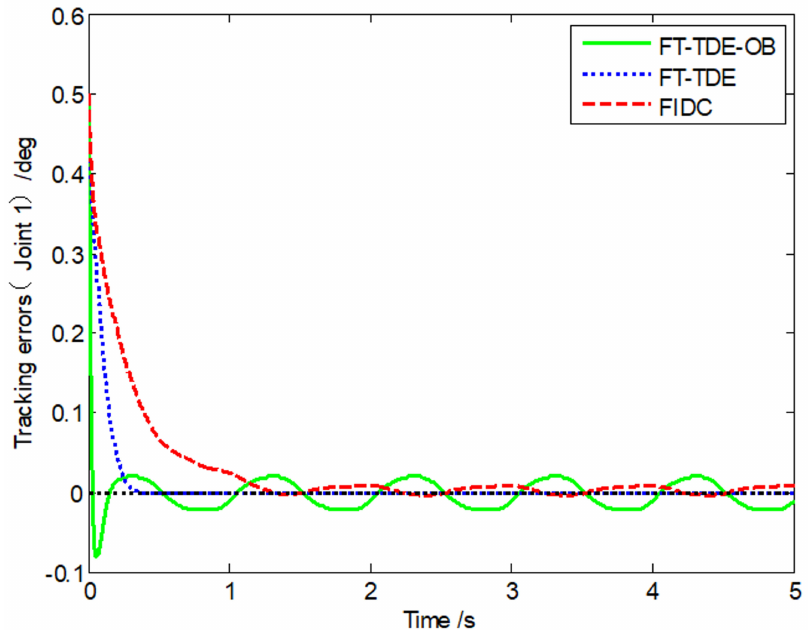
Figure 5. Tracking errors of Joint 1.